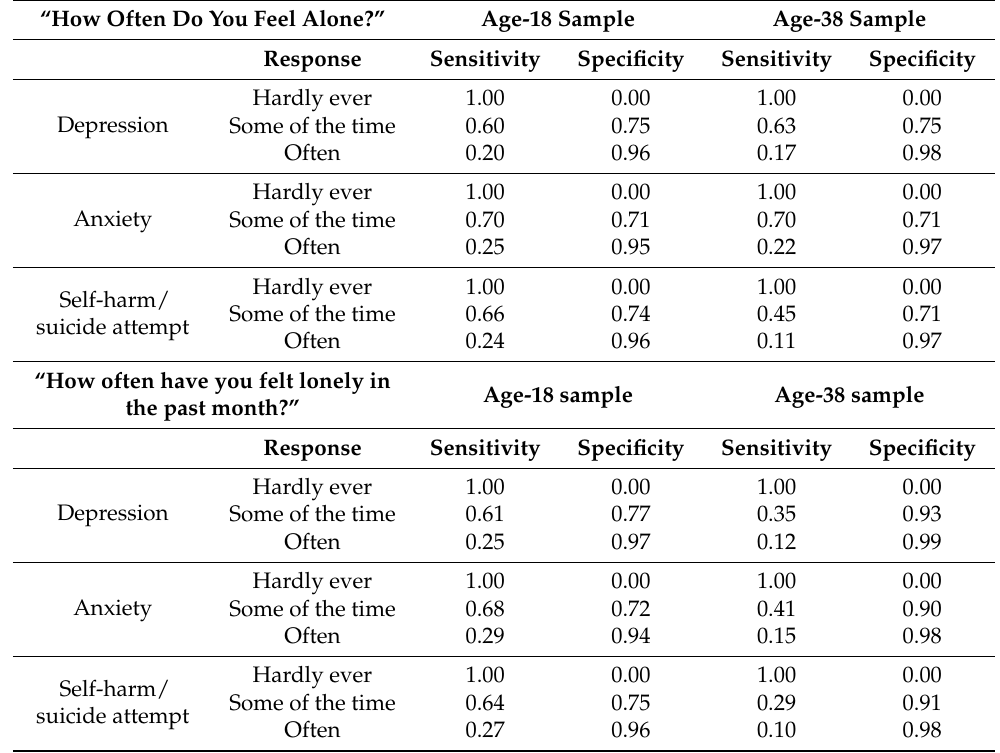
Table 3. Accuracy of individual loneliness items in classifying mental health